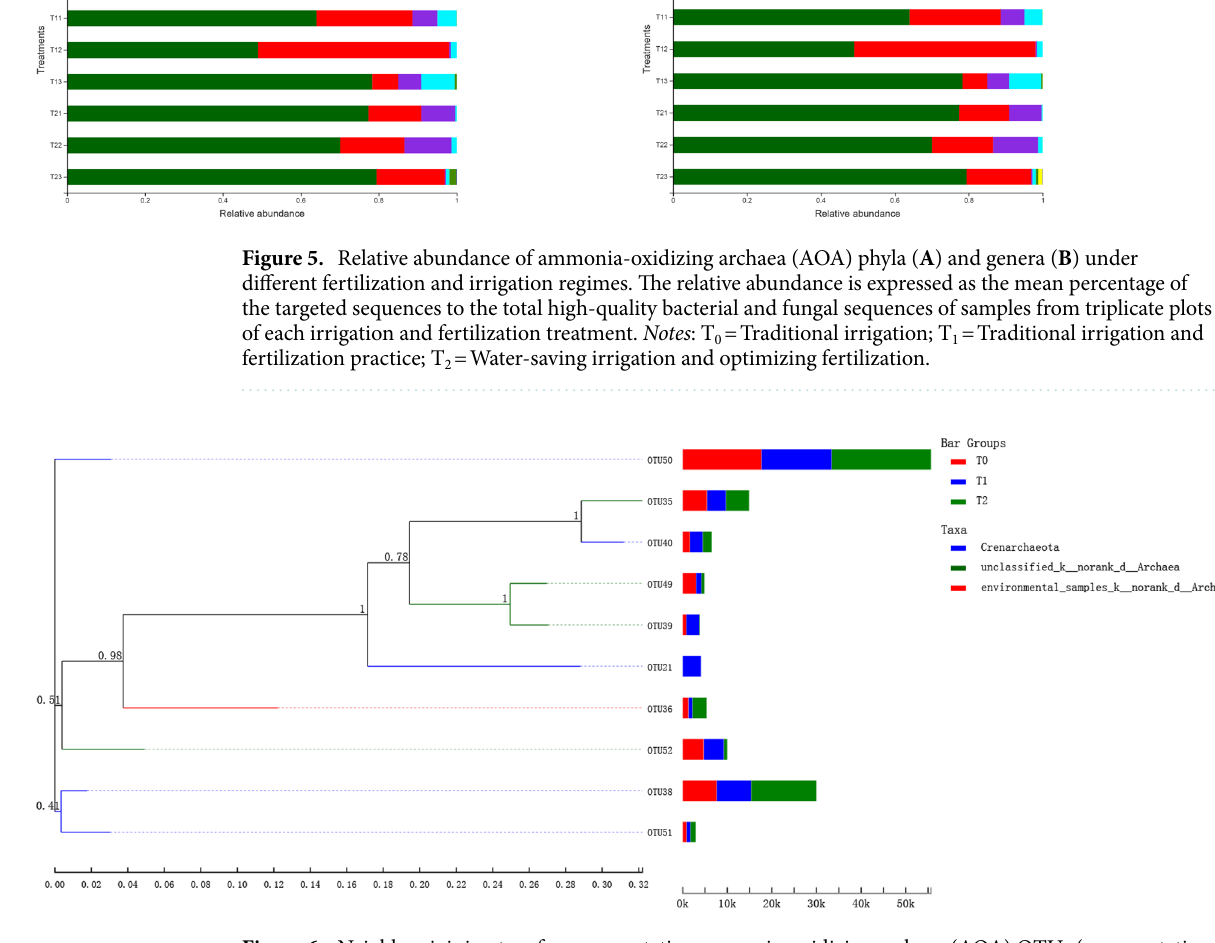
Figure 6. Neighbor-joining tree for representative ammonia-oxidizing archaea (AOA) OTUs (representatives with relative abundance of the top 10 most abundant species). Bootstrap values (> 50%) were indicated at branch points. OTUs from this study were shown in bold. Notes : T 0 = Traditional irrigation; T 1 = Traditional irrigation and fertilization practice; T 2 = Water-saving irrigation and optimizing